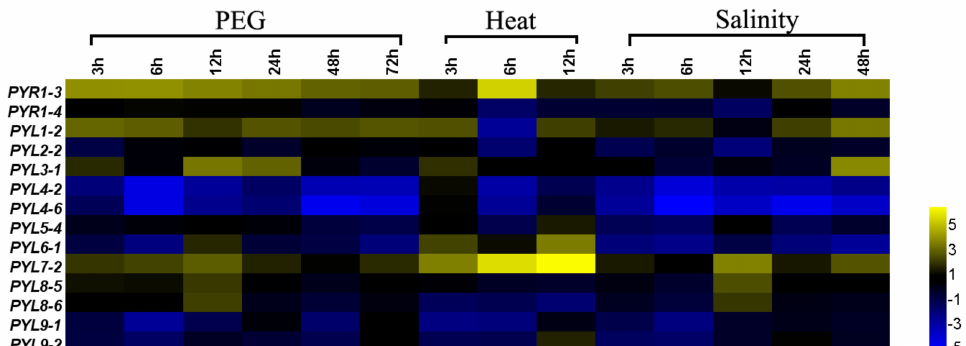
Figure 7. PYL expression levels under drought, salinity and heat abiotic stresses in B. napus . The bars display the relative gene expression levels, calculated based on the 2 − ∆∆ Ct method. The expression level is equal to the mean values and transform log 2 values. polyethylene glycol (PEG), drought stress; Heat, high-temperature stress; Salinity, salt